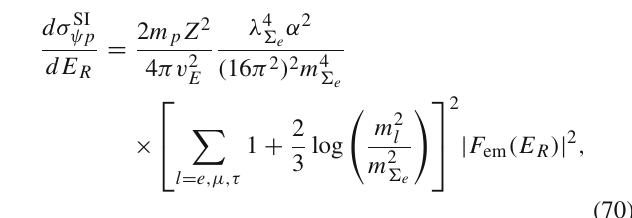
Fig. 17 The same as Fig. 16 but in the ( m (cid:19) plane for the case of a Dirac (top panel) or Majorana (bottom panel) fermion DM and scalar t-channel mediator (cid:19) u . The coupling λ (cid:19) been set to 1. For the Majorana fermion DM case, unlike the Dirac one, only boundaries of DD limits are shown. In the case of Majorana fermion DM we have also reported the excluded region (orange) by combined LHC limits from monojet and dijet+missing energy events [140,284]. Similar limits for the cases of Dirac fermion and complex scalar DM have been omitted since they are irrelevant with respect to DD